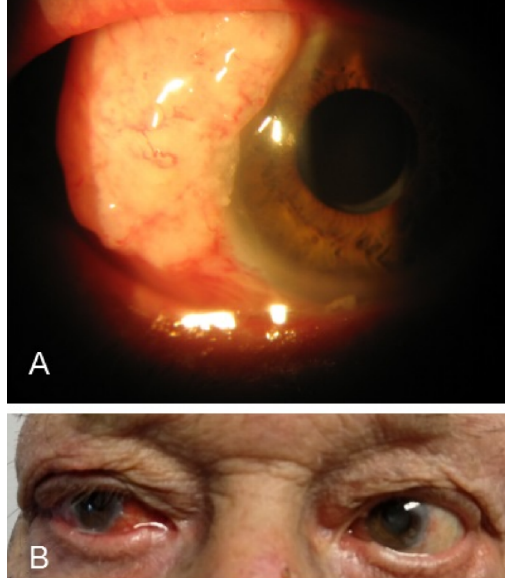
Figure 4: A) Slit-lamp examination: a gelatinous temporal conjunctival mass (7x10 mm) with dilated superficial vessels without corneal involvement is exposed. B) Abduction limitation in right